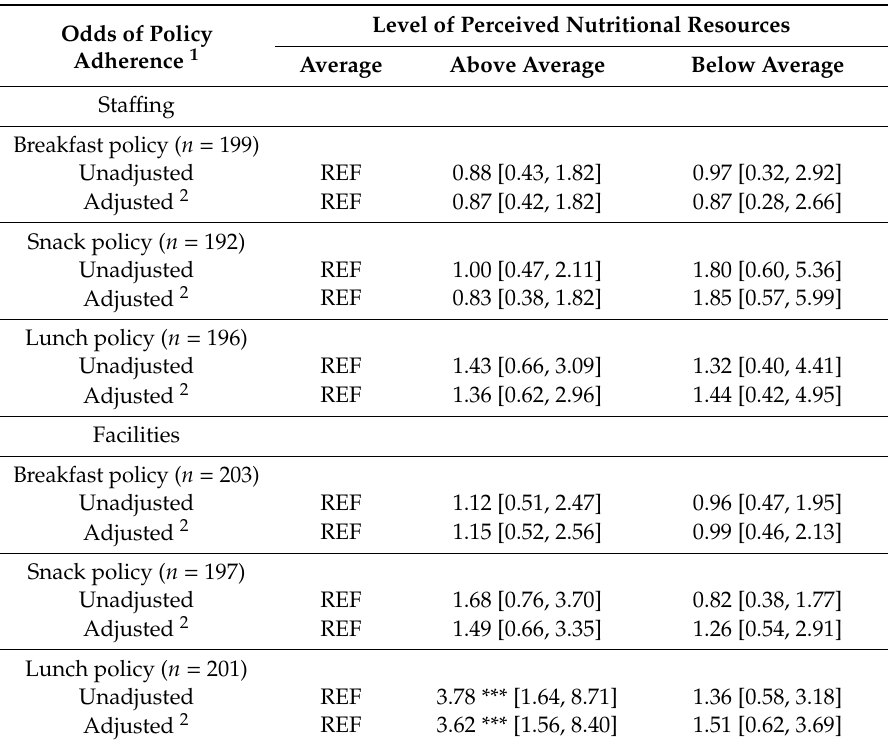
Table 2. Odds ratios and 95% confidence intervals for breakfast, snack and lunch policy adherence by level of perceived nutritional resources including adequate sta ffi ng and